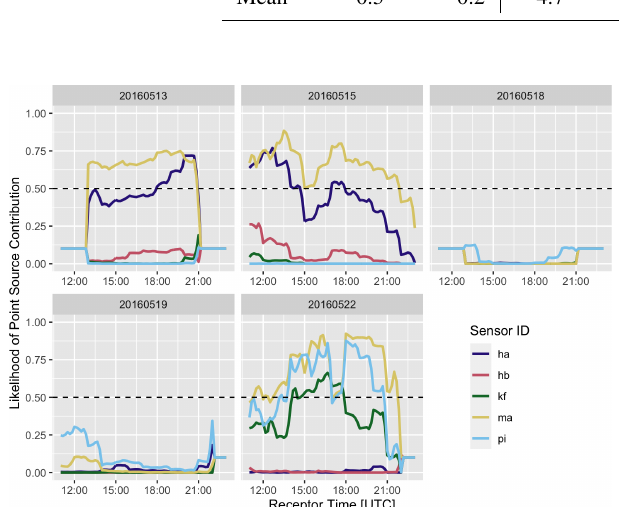
Figure 8. Standard deviations due to uncertainties in horizontal transport for the entire